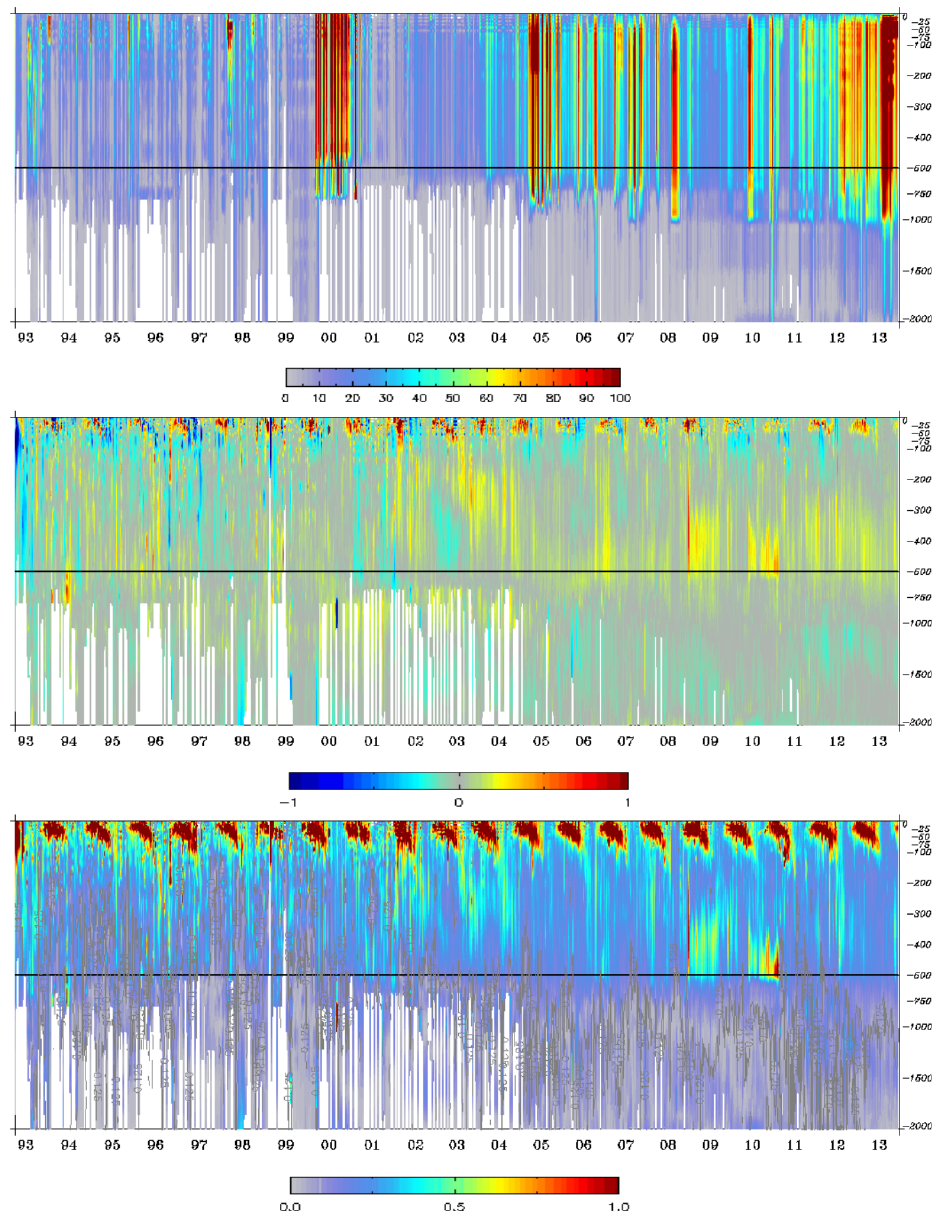
Figure 5. Evolution of weekly temperature data assimilation statistics from in situ profiles, function of the depth averaged over the whole Mediterranean basin : number of observations (top), mean innovation (middle) and rms of the innovation